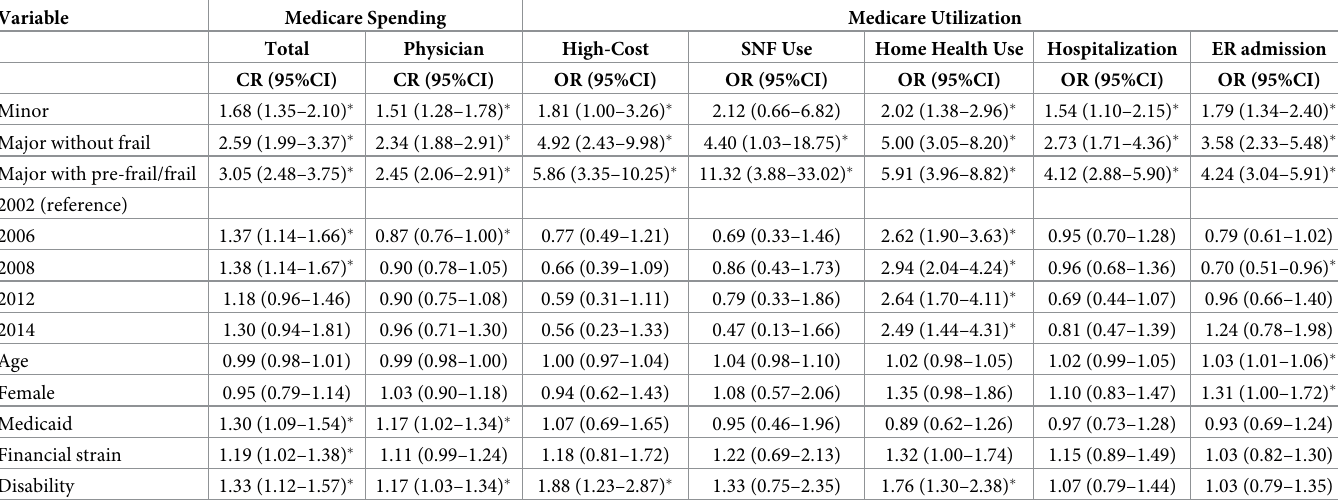
Table 3. The impact of population segment combined with frailty on Medicare spending and utilization.